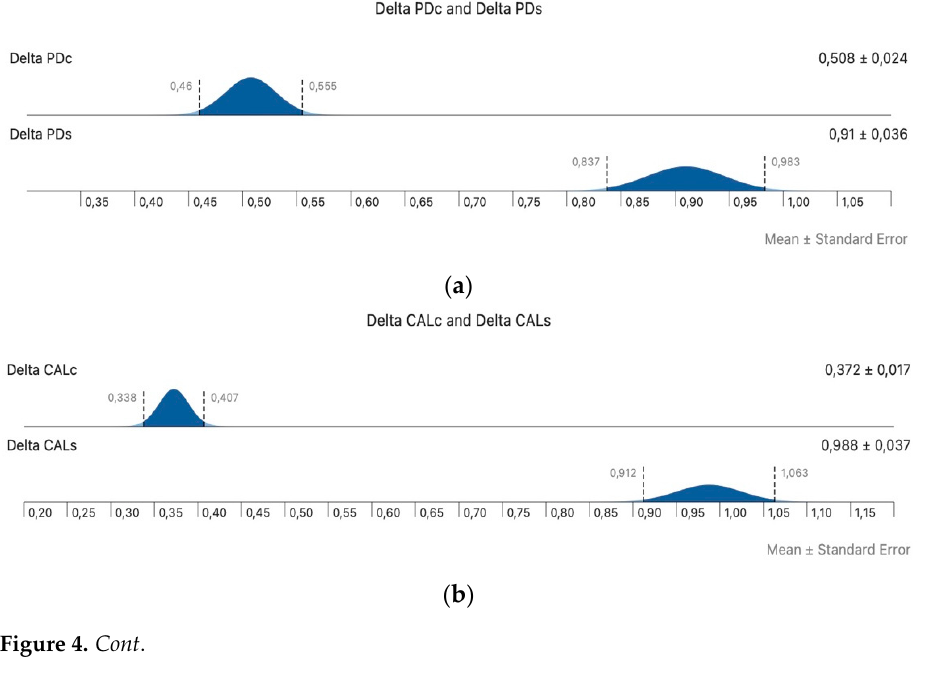
Figure 3. Comparaison at baseline and 3 months in study group between ( a ) probing depth values (PDc: probing depth in SRP + L. reuteri sites); ( b ) clinical attachment loss (CALc: clinical attachment loss in SRP + L. reuteri sites); ( c ) bleeding on probing values (expressed in %) (BOPc: bleeding on probing in SRP + L. reuteri sites).